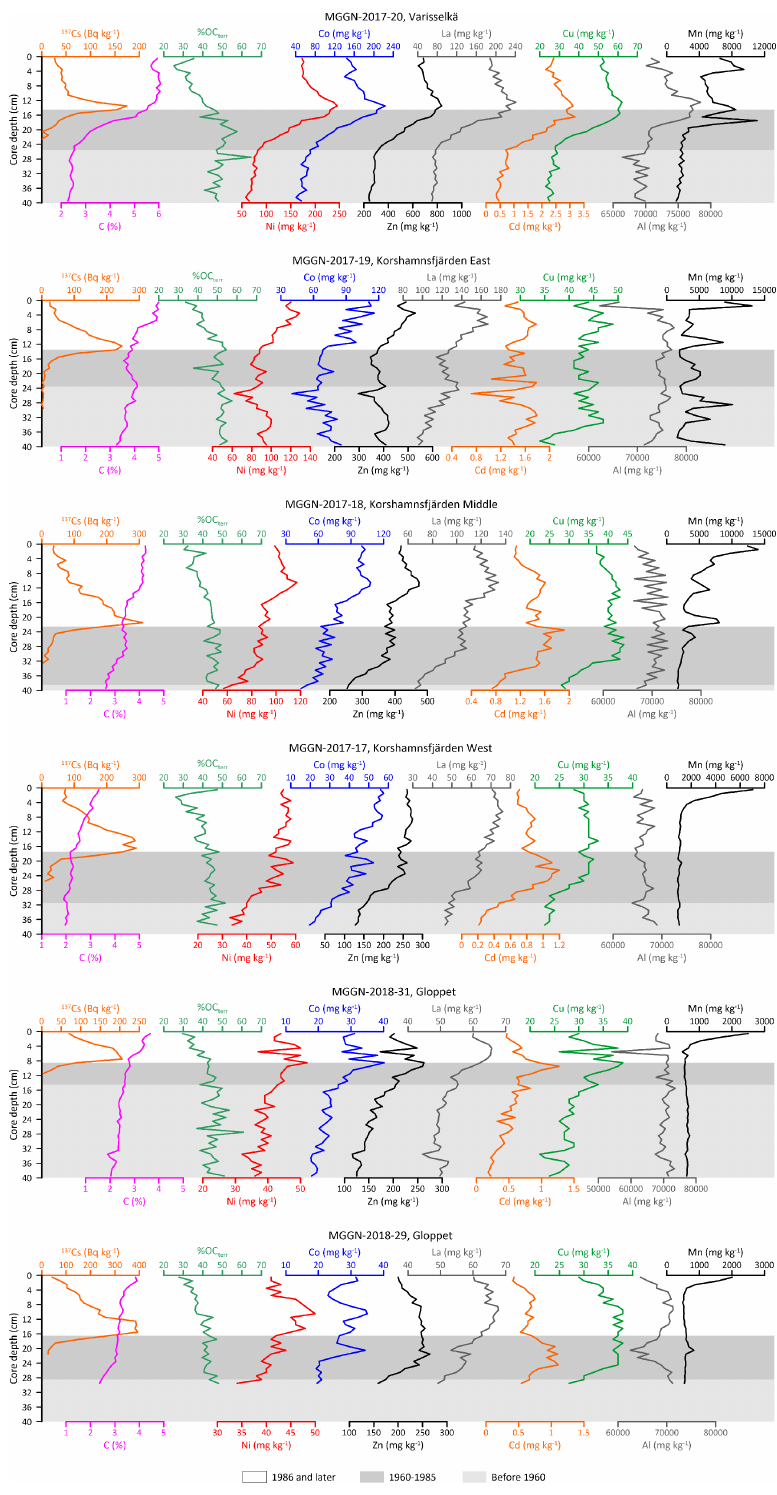
Figure 2. Vertical distributions of 137 Cs, carbon, the share of terrestrial organic carbon, and the contents of metals typically leached from acid sulfate soils in the < 63µm grain size fraction of representative sediment cores in the Kvarken Archipelago. The cores are arranged according to increasing distance from the Laihianjoki and Sulvanjoki rivers (downward). The dark grey shading indicates the interval deposited between 1960 and 1985, and the light grey shading indicates the interval deposited before the year 1960 in each core. The intervals without shading were deposited in 1986 and